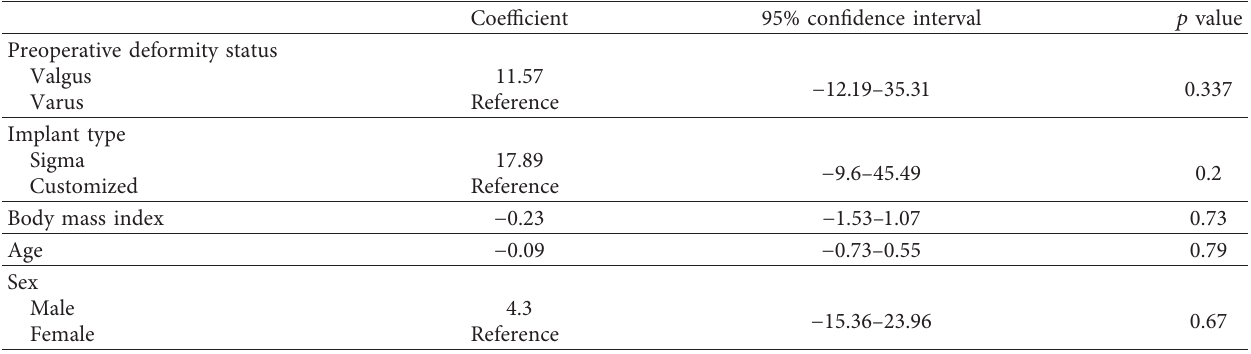
Table 4: Regression analysis on leg length (R-square � 0.04, p � 0.49).